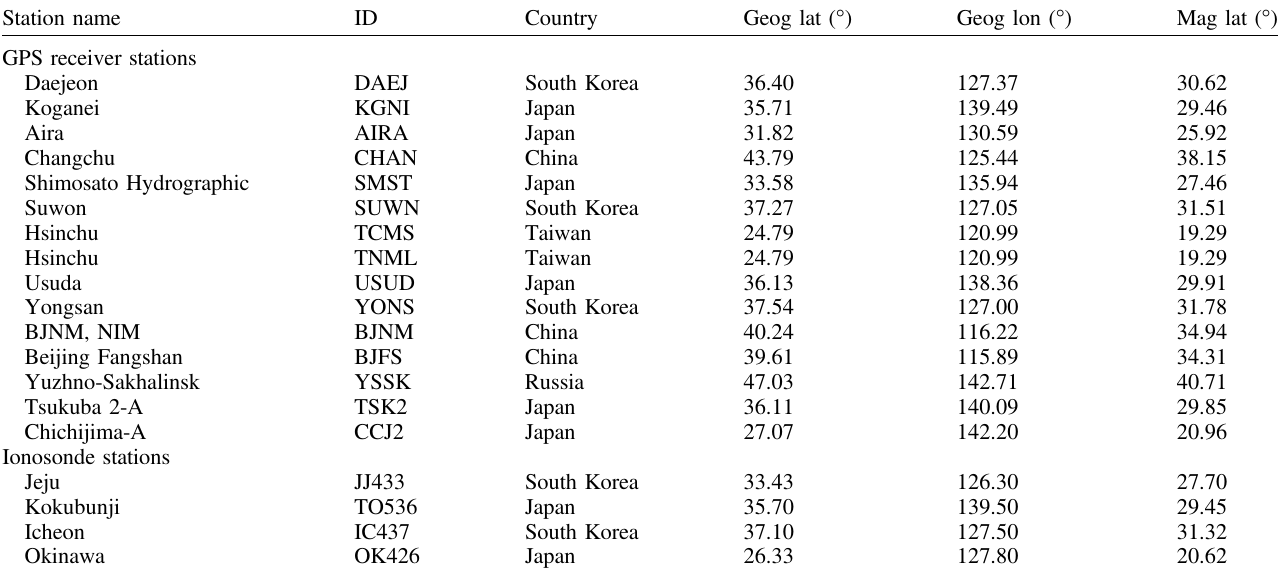
Table 1. Geophysical parameters of GPS and ionosonde stations used in the study. Station name GPS receiver stations